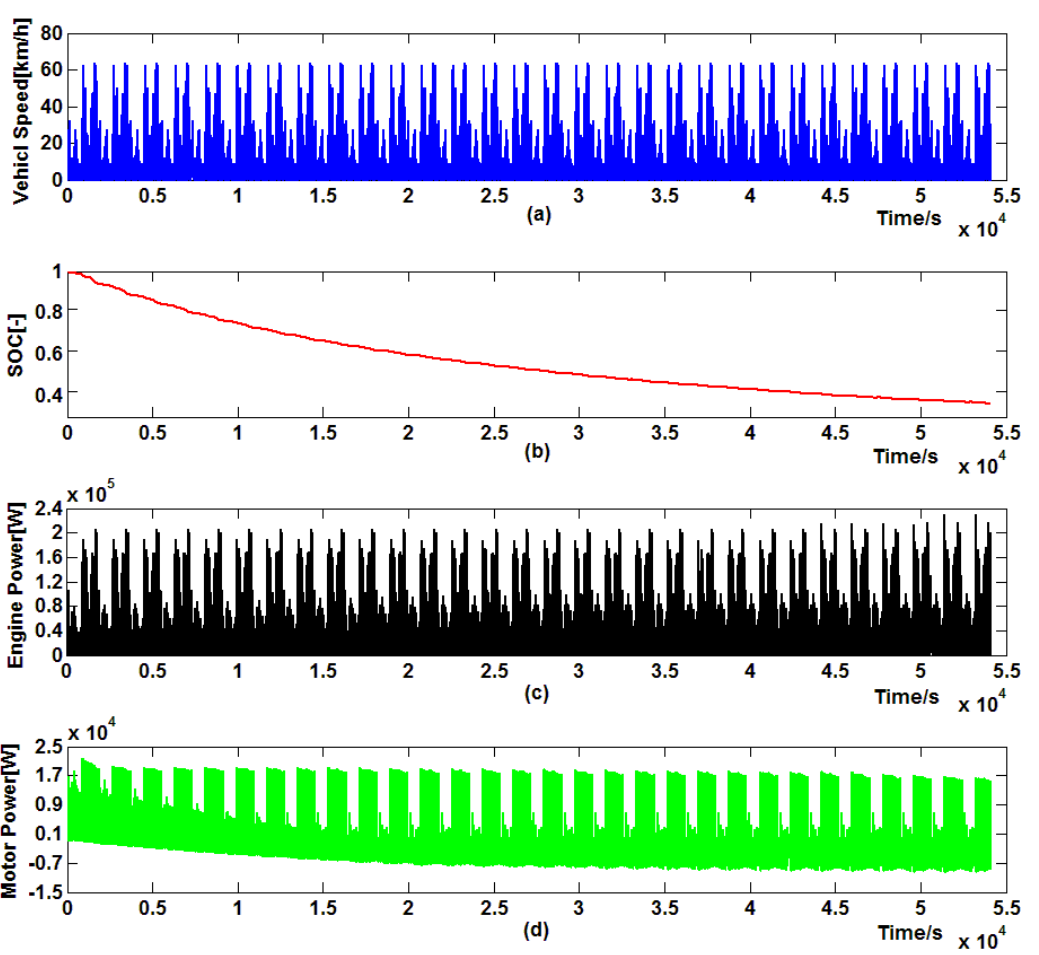
Figure 13. Overall simulation results of PHEB in real-time control strategy. ( a ) vehicle speed; ( b ) the battery SOC ; ( c ) engine power; ( d ) motor power.